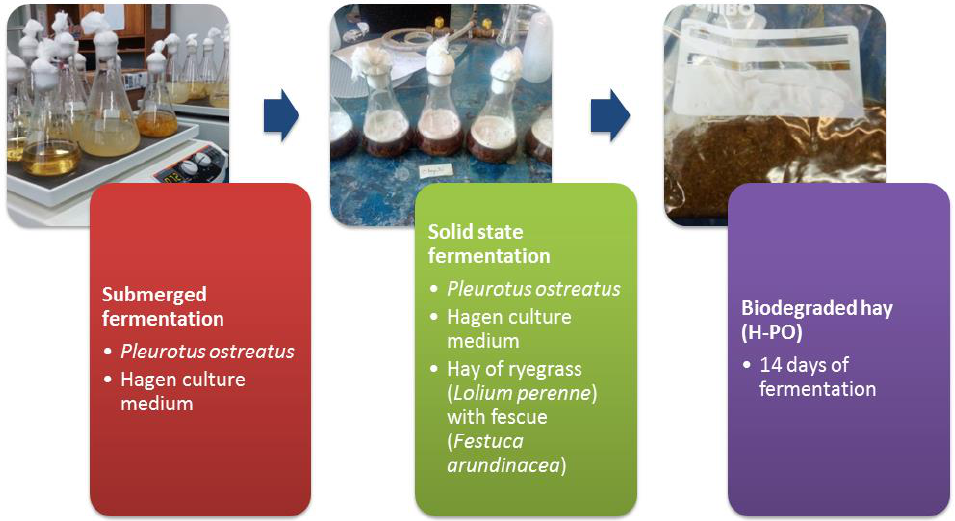
Figure 5. Flow chart for the production of biodegraded hay with P. ostreatus.